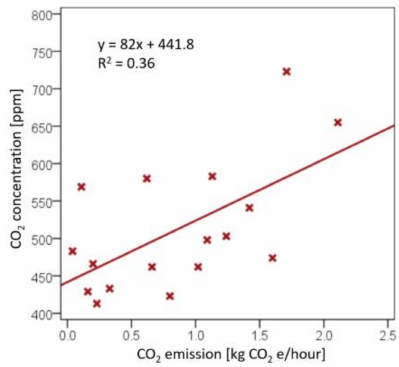
Figure 10. Relationship between CO 2 emissions and concentrations.